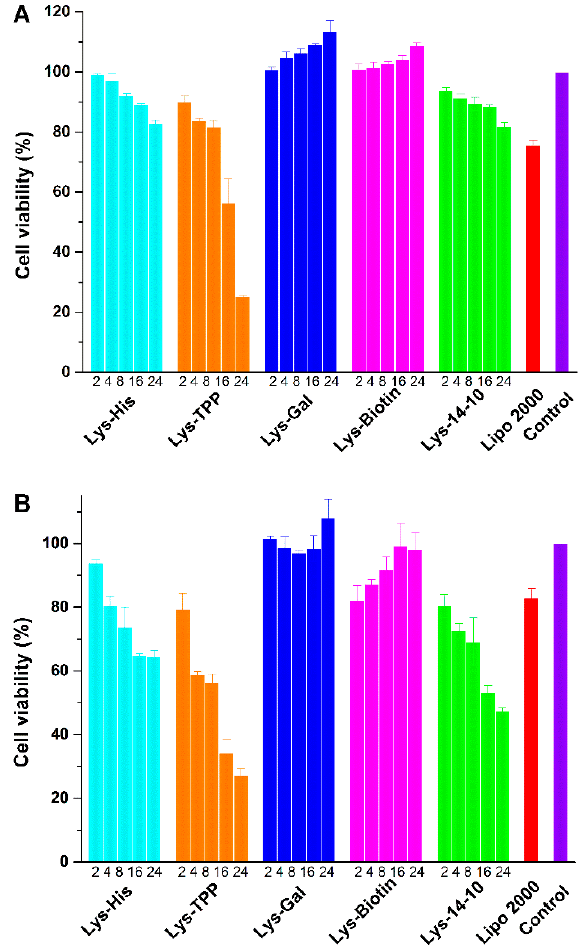
Figure 7. In vitro cytotoxicity of the bolaplexes at various N/P ratios in HEK 293 ( A ) and HeLa cells ( B ) for a 24 h incubation. Data represent mean ± SD ( n = 3).